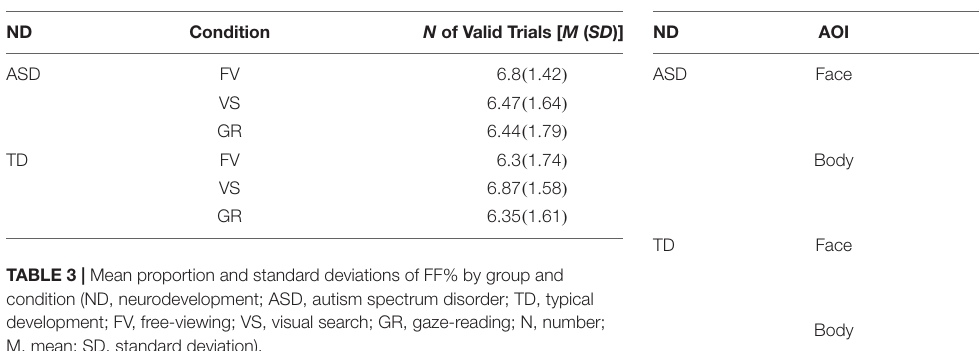
TABLE 2 | Number of valid trials per condition for each participants’ group (ND, neurodevelopment; ASD , autism spectrum disorder; TD, typical development; FV, free-viewing; VS, visual search; GR, gaze-reading; N, number; M, mean; SD, standard deviation).